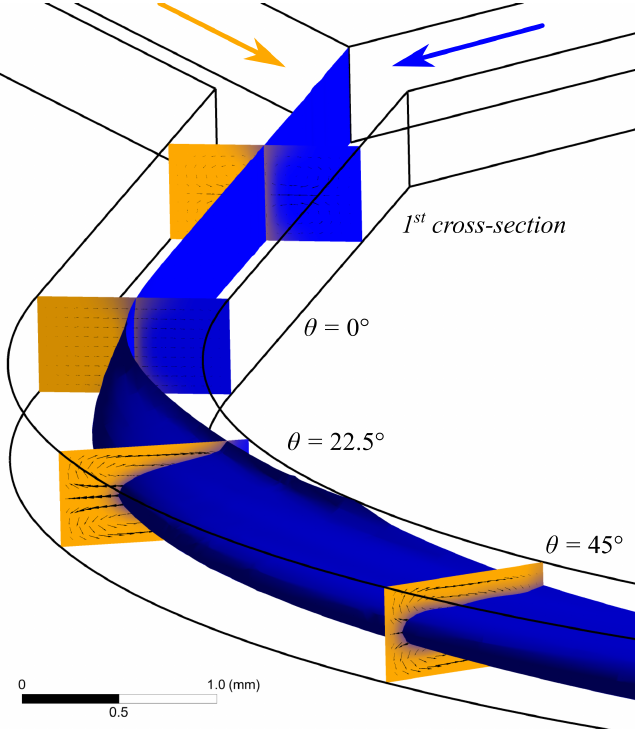
Figure 3. Results of computer simulation performed in application AnsysFluent illustrates appear- ance of secondary vortex in curved channel with water flow rate at 5 mL/min. Isosurface of the volumetric fraction of the liquid phase. The arrows show the velocity vector field. The flows at angle 50.5 ◦ corresponding to the SI 90 are used for measuring